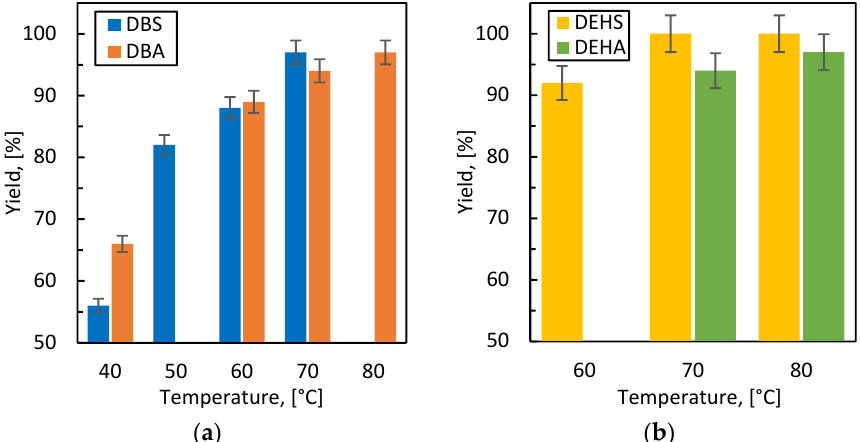
Figure 4. The influence of the temperature on the on the esterification of succinic and adipic acid with ( a ) butan-1-ol and ( b ) 2-ethylhexan-1-ol. Reaction conditions: alcohol 4 mol; acid 1 mol; IL 2.7 (15 mol%/mol succinic acid (0.0025 mol)); 17 Hz; reaction time 120 min.